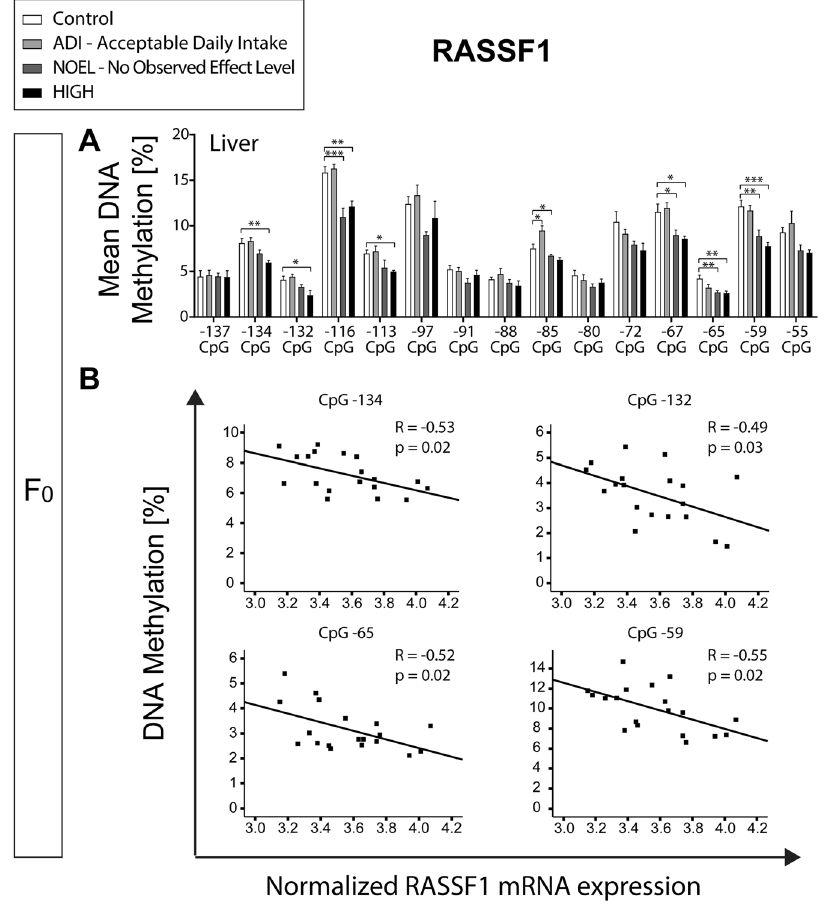
Figure 6. E2 induced DNA hypomethylation in the RASSF1 5 ′ UTR of the F 0 liver. Bar charts represent mean ± SEM of % DNA methylation per group in different shades of grey (0.05, 10, and 1000 μ g/kg body weight/day represented by ADI, NOEL, and HIGH dose, respectively). * , ** , and *** indicate statistical significance with respect to the control group at p < 0.05, p < 0.01, and p < 0.001, respectively (n = 4–6 per group). ( A ) Liver DNA methylation showing most pronounced hypomethylation at CpG − 134, − 132, − 116, − 113, − 85, − 72, − 67, − 65, and − 59. ( B ) Significant correlation of mRNA expression of RASSF1 with its methylation levels at CpG − 134, − 132, − 65, and −